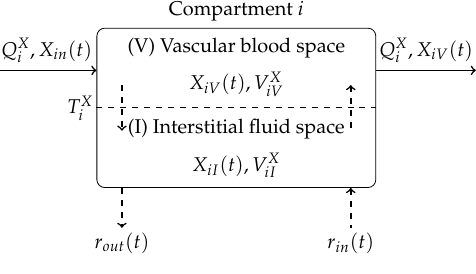
Figure 3. Basic compartment i of the blood glucose model illustrating mass exchange of substance X